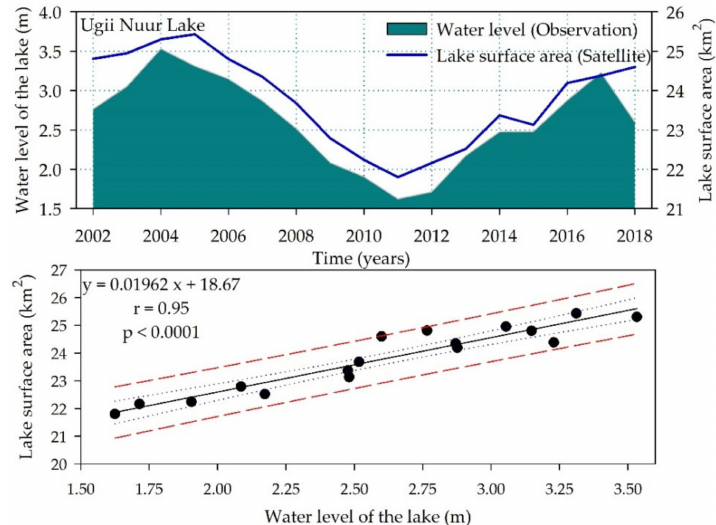
Figure 6. Linear regression for a relationship between water level and surface area of the Ugii Nuur